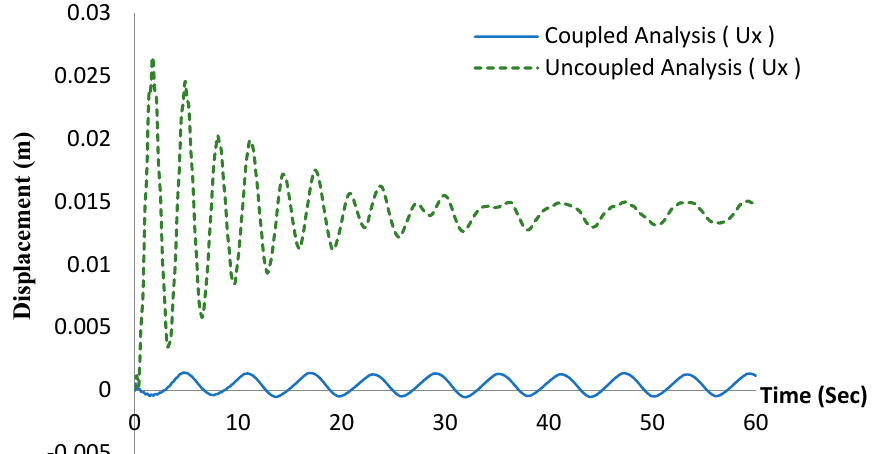
Figure 14. Comparison of deflections in the x- direction resulting from couple and uncouple analyses.